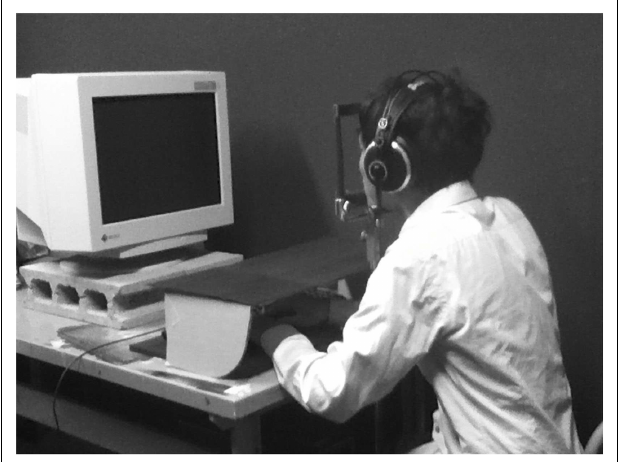
FIGURE 1 |Apparatus. Observers couldn’t hear keypresses because of white noise via headphone and couldn’t, see their hands because of a